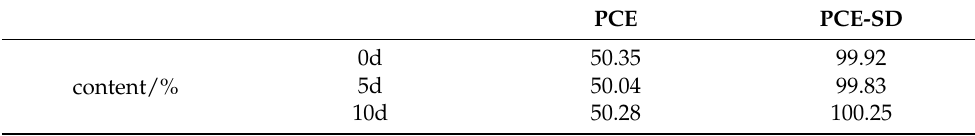
Table 7. The content of PCE and PCE-SD under high temperature conditions.